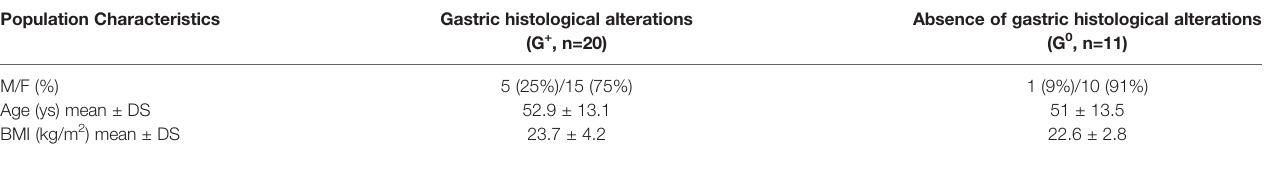
TABLE 2 | Demographic data and histological status of the study population. Population Characteristics Gastric histological alterations